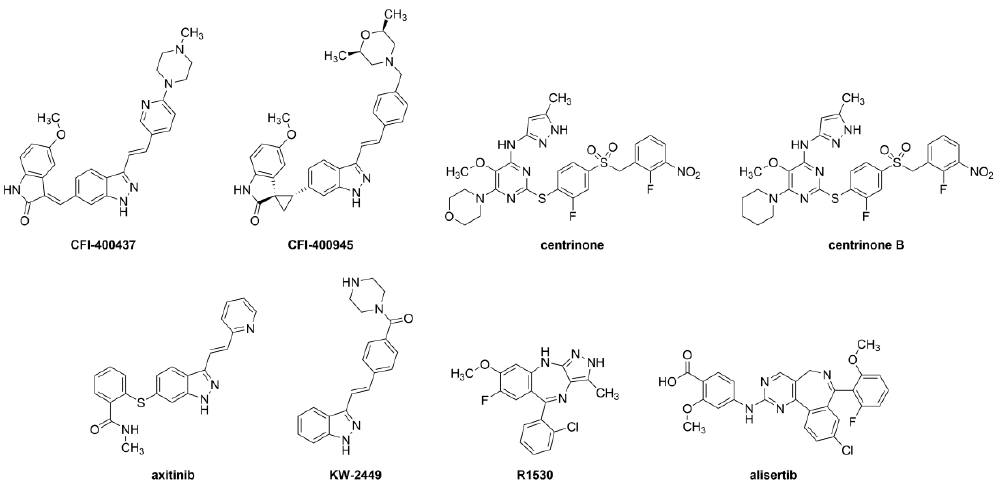
Figure 1. Chemical structures of the evaluated protein kinase